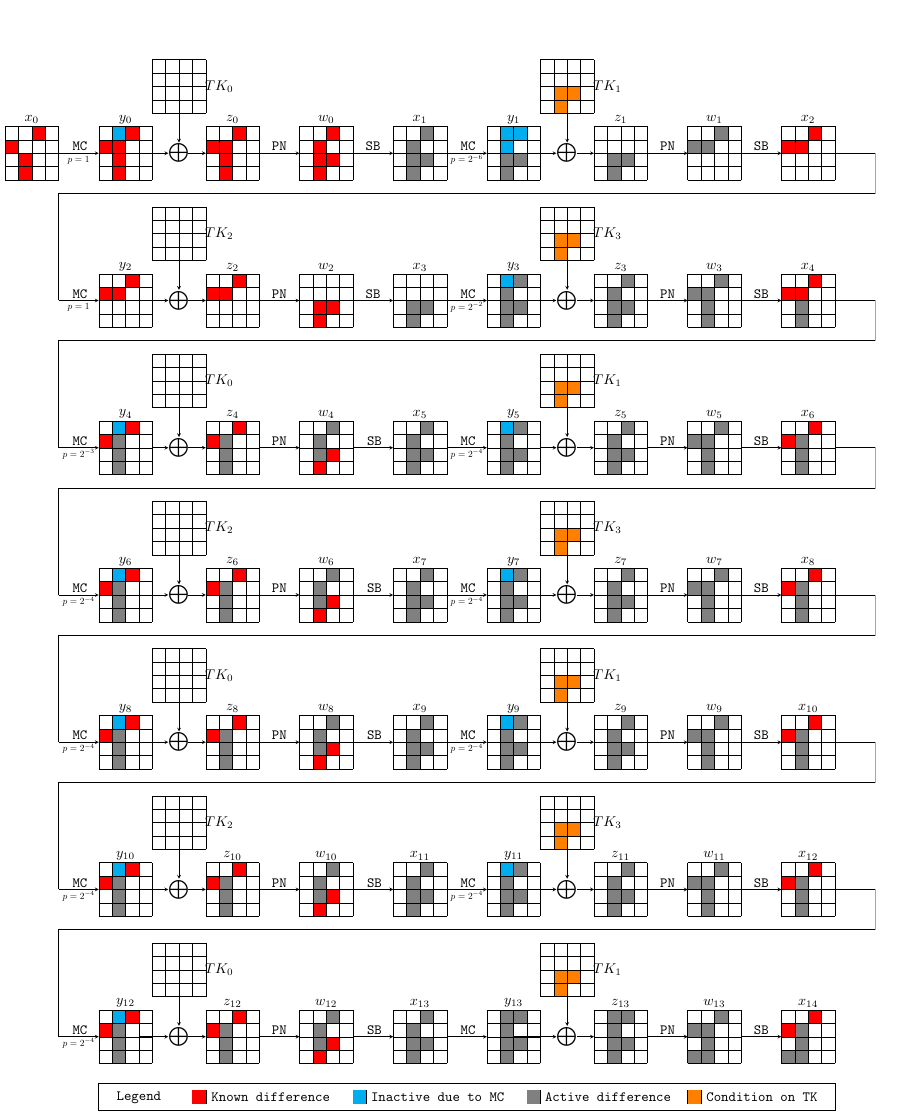
Figure 14: A 14-round truncated differential trail of CRAFT with probability 2 − 43